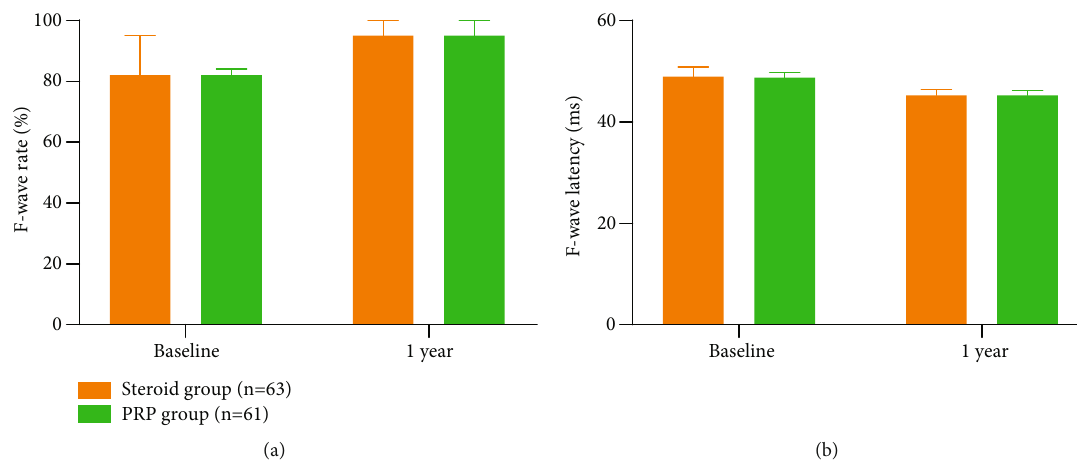
Figure 4: Comparison of F-wave rate and latency between the PRP ( n = 61 ) and steroid ( n = 63 ) groups. No signi fi cant di ff erence was found in terms of F-wave (a) rate and (b) latency between the PRP group and the steroid group both before and after operation. The error bars represent the 3rd